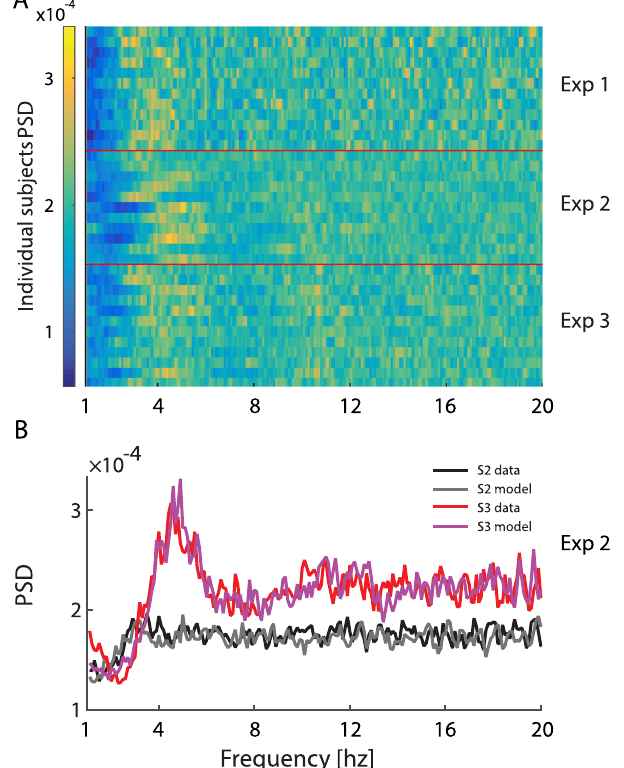
Figure 1. Spectra of saccade sequences. ( A ) Power spectra of saccade sequences. Each row represents the 1–20 Hz normalized power spectrum density of an individual observer. For convenience of presentation, we normalized each data-set’s power spectrum to the fraction of the overall power. ( B ) Same data for two selected observers. While one (S3-red line) has a distinctive spectral peak, the other’s spectrum is nearly flat (S2-black line). With different parameters, our first-order model can fit both types of data-sets (purple and gray